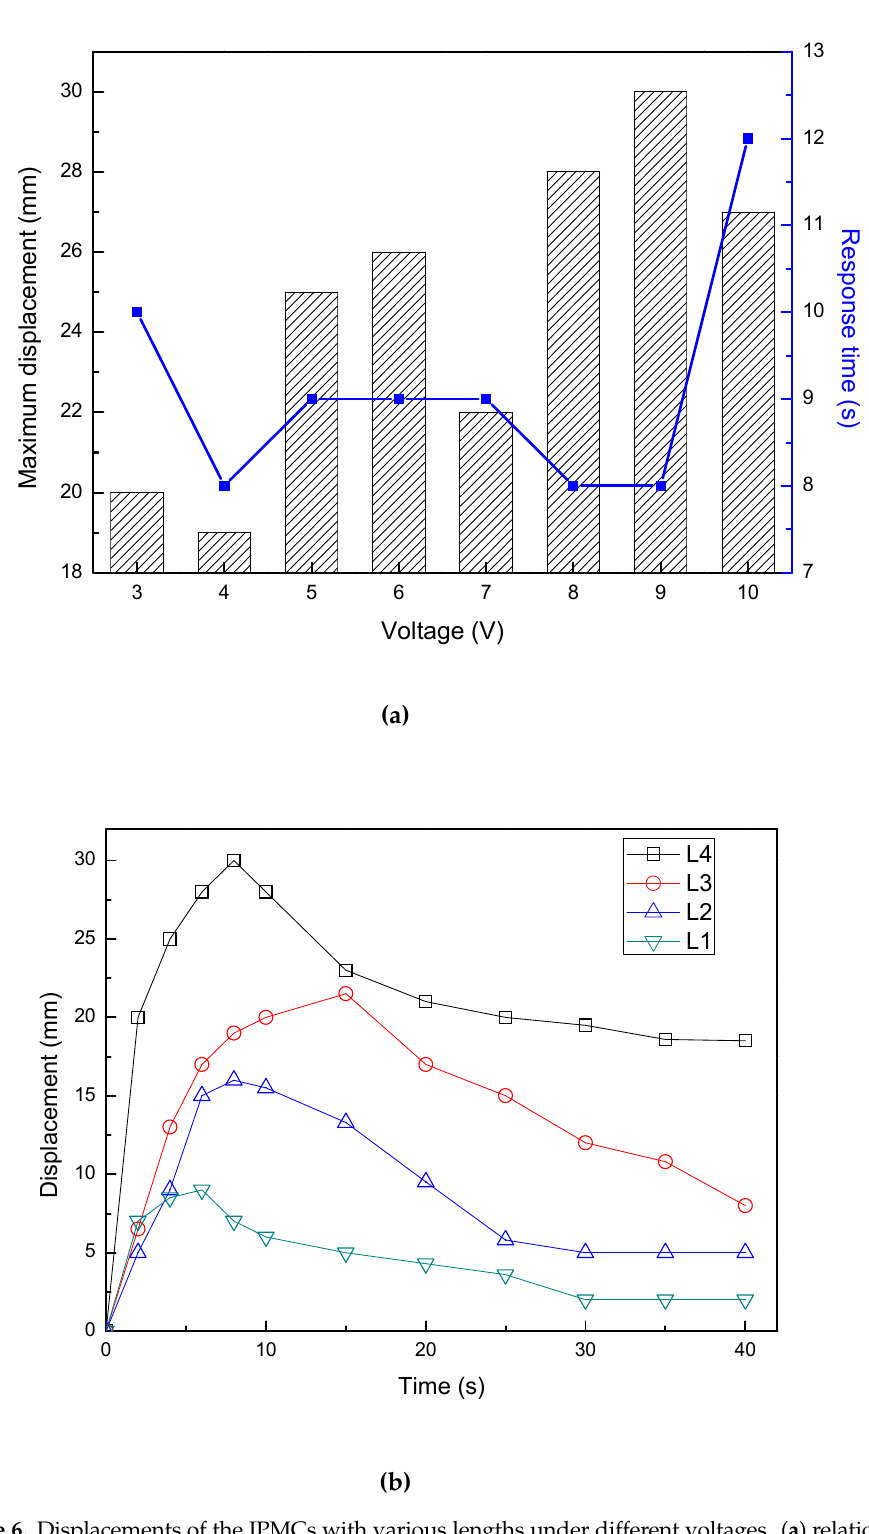
Figure 6. Displacements of the IPMCs with various lengths under different voltages. ( a ) relationships between the maximum displacement or the response time and voltage for L4 sample; ( b ) displacement–time curves of 9 V.